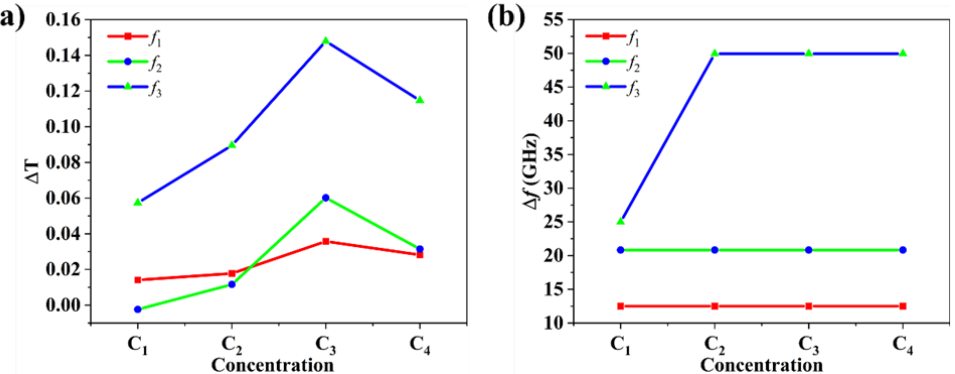
Figure 5. ( a ) The amplitude changes of the sensor under the influence of different concentrations of OVA. ( b ) The frequency changes of the sensor under the influence of different concentrations of